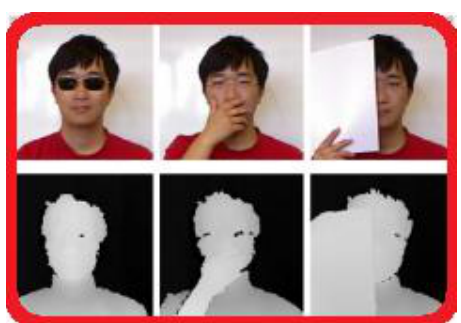
Figure 36. Occlusions by sunglasses, by hand and by paper. Upper: the RGB (red green blue) images. Lower: the depth maps aligned with above RGB images.